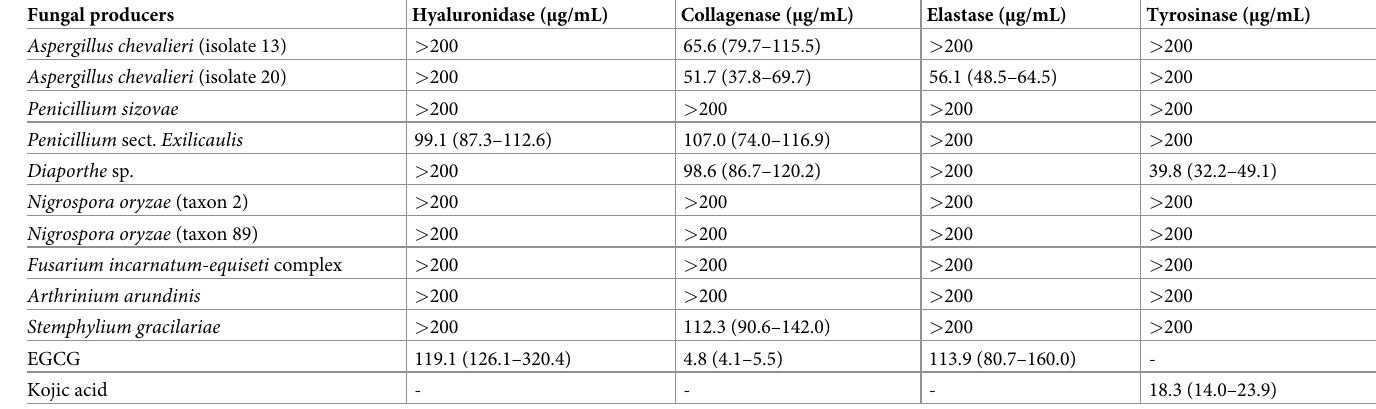
Table 3. Concentration of the fungal crude extracts that causes 50% inhibition of an enzymatic reaction (IC 50 ). Fungal